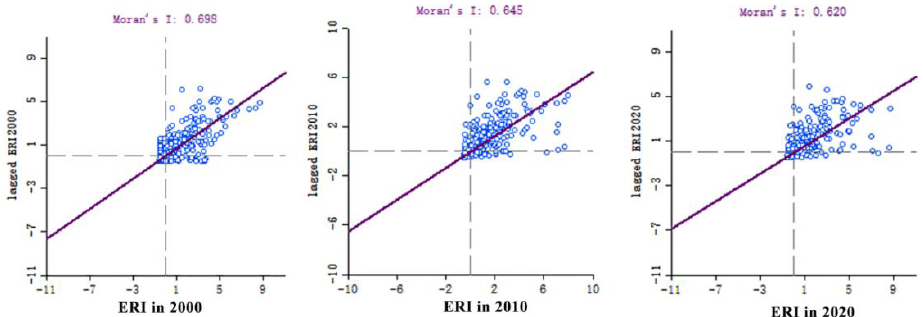
Figure 7. Moran’s I index scatter distribution of the landscape ecological risk values in the Shaanxi Yellow River Basin from 2000 to 2020.